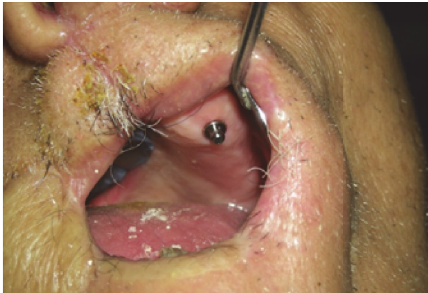
Figure 8: Overdenture attachment in place.